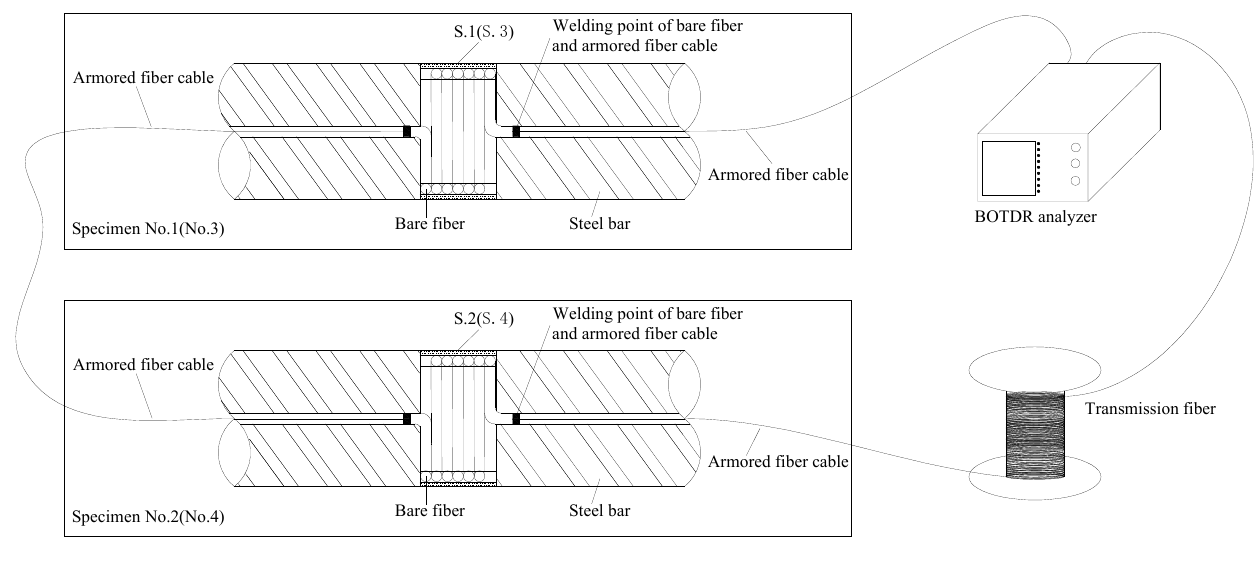
Figure 10. Fiber optic circuit of the corrosion monitoring experiments.